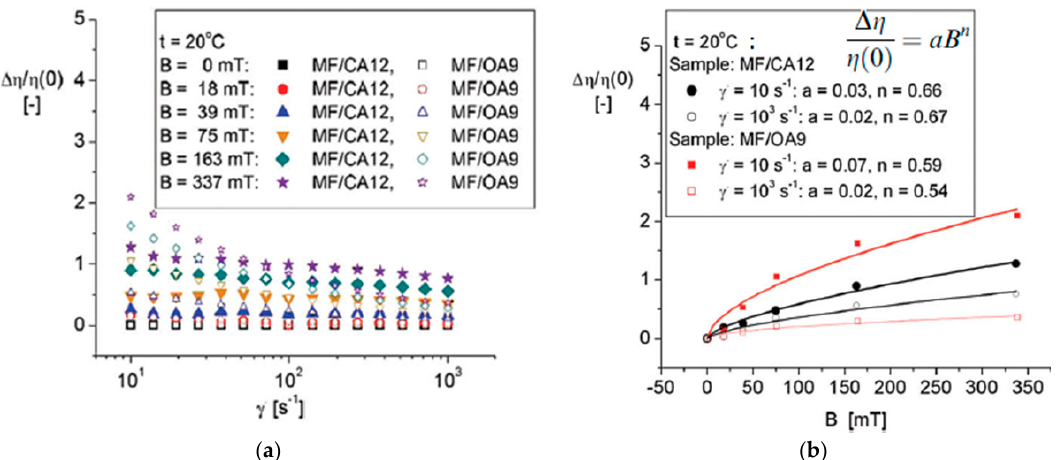
Figure 21. ( a ) Magnetoviscous effect (MVE) dependence on the shear rate at different magnetic flux densities; ( b ) MVE dependence on the magnetic flux density at two shear rate values. Reproduced from Reference [85] with permission from The Royal Society of Chemistry.